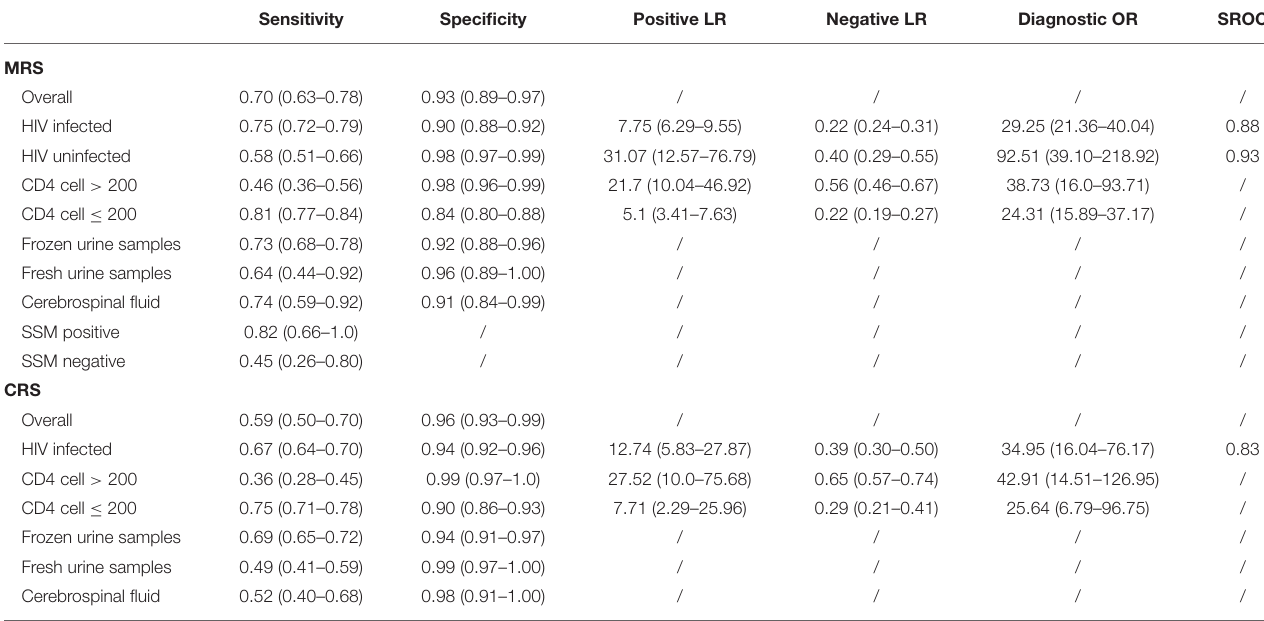
TABLE 1 | Pooled results of FujiLAM in the diagnosis of adult patients with tuberculosis.